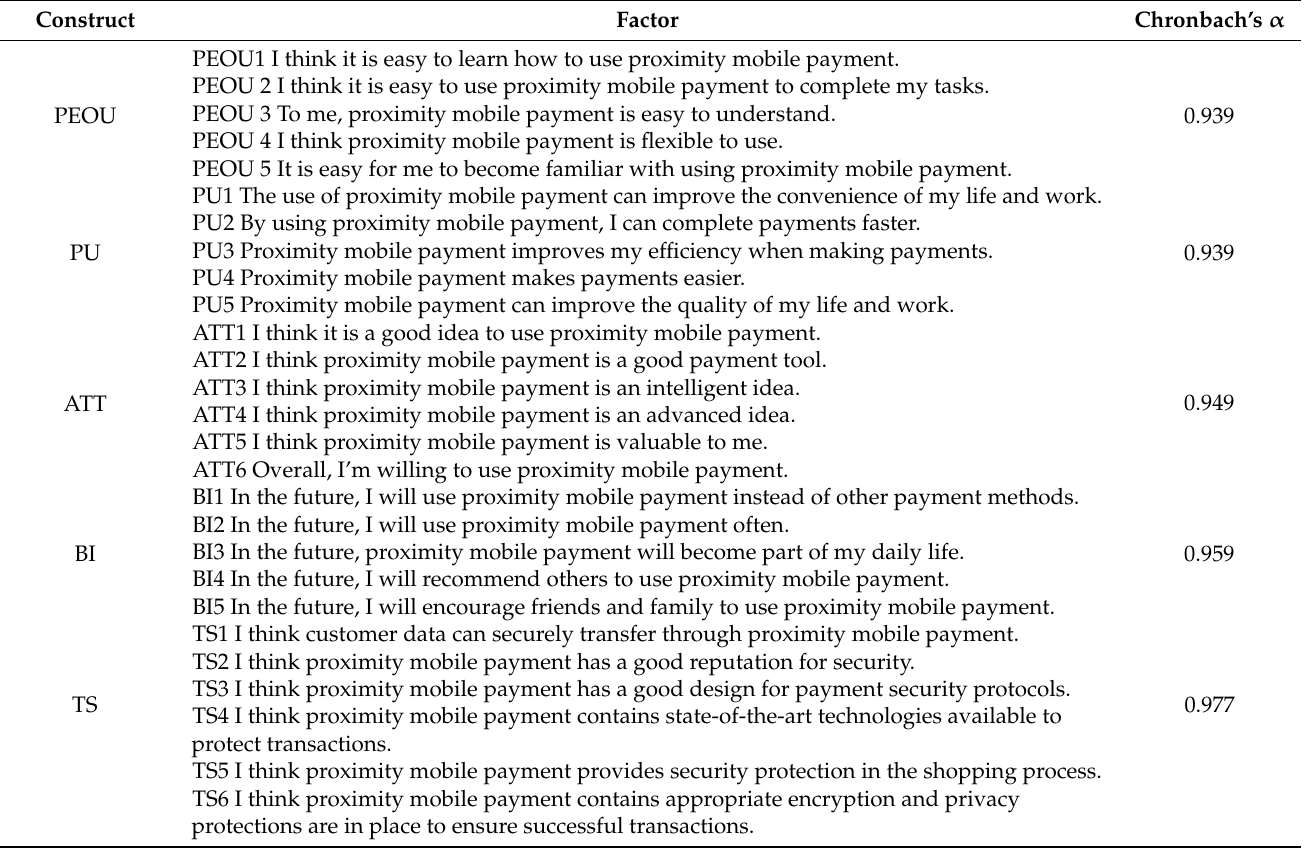
Table 6. CFA of perceived usefulness.